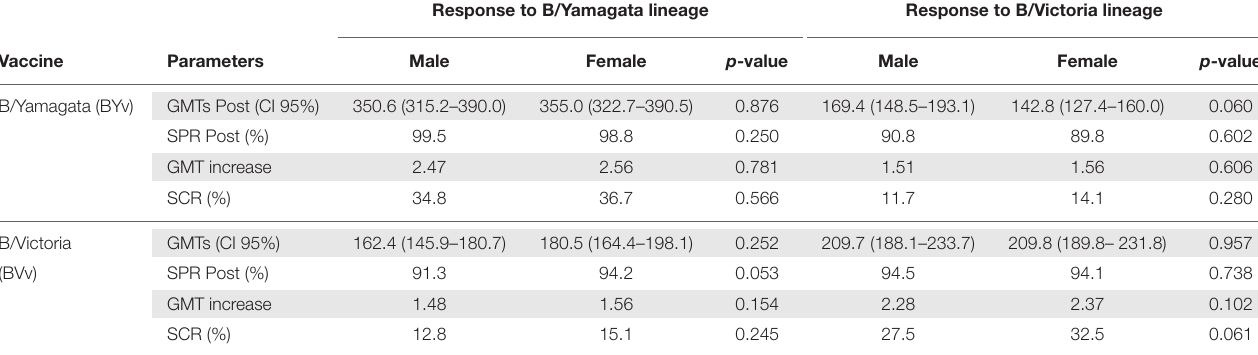
TABLE 3 | Comparison of the response to vaccination with BYv and BVv between males and